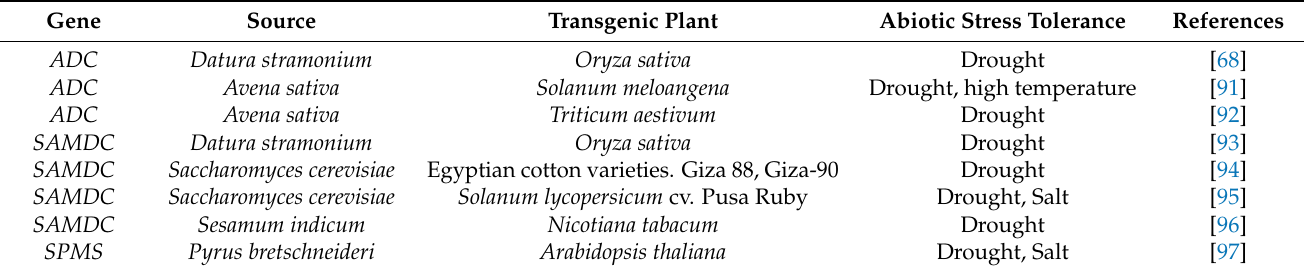
Table 2. Spermine biosynthetic genes involved in tolerance to drought and other abiotic stresses in plants.